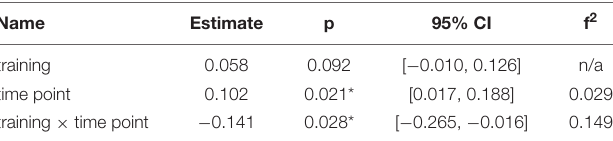
TABLE 3 | Generalized linear mixed-effects model results for average MD in the right ILF for older participants.